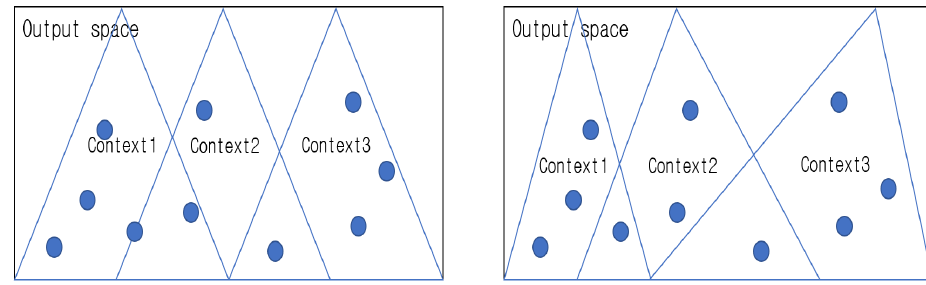
Figure 4. Shape of IGs generated through the information granulation method.